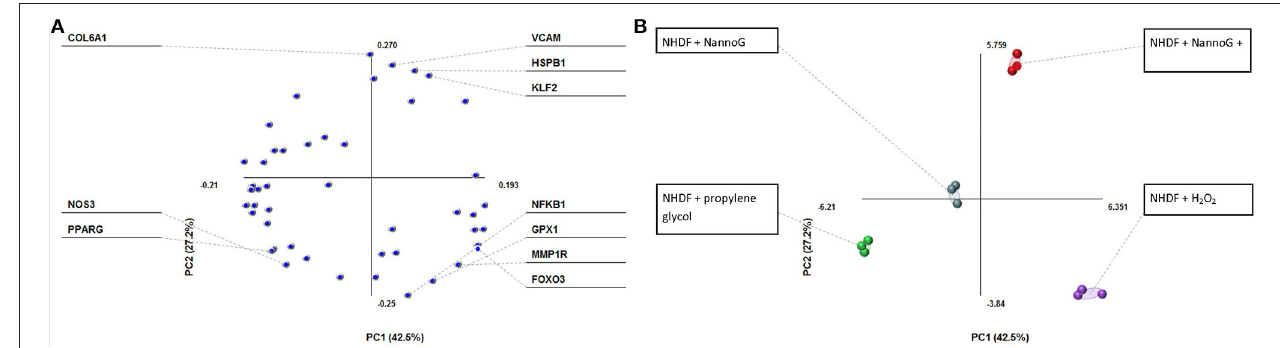
FIGURE 3 | Principal component analysis (PCA) of transcript of genes into four experimental conditions: cells treated with NannoG, cells treated with propylene glycol (control), cells treated with H 2 O 2 and cells treated with NannoG and H 2 O 2 . (A) Score plots of PCA, PC1:42.5% and PC2:27.2% based on four experimental conditions: cells treated with NannoG (light blue dots), control cells (green dots), cells treated with H 2 O 2 (purple dots) and cells treated with NannoG first and then with H 2 O 2 (red dots). (B) Loadings of individual identified components showing the highest variability under the studied experimental conditions.